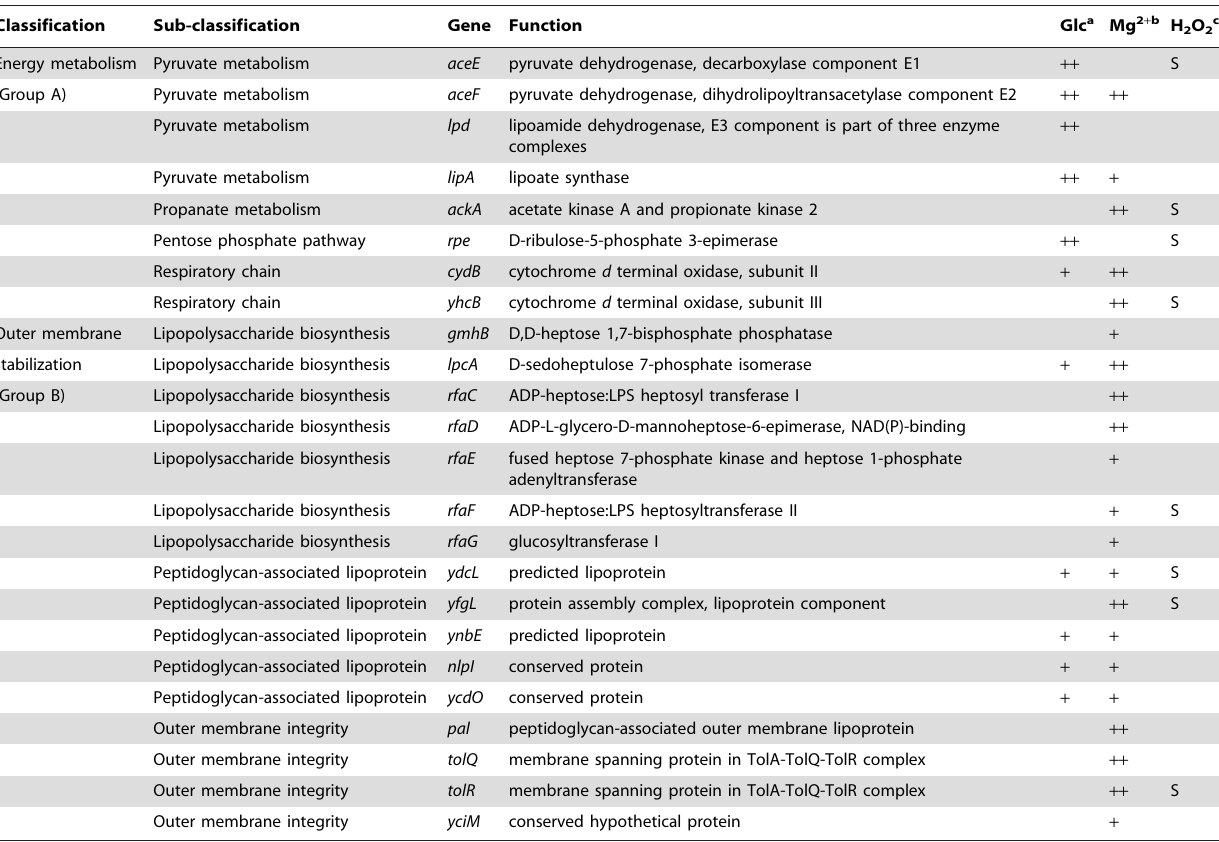
Table 1. Thermotolerant genes identified in this